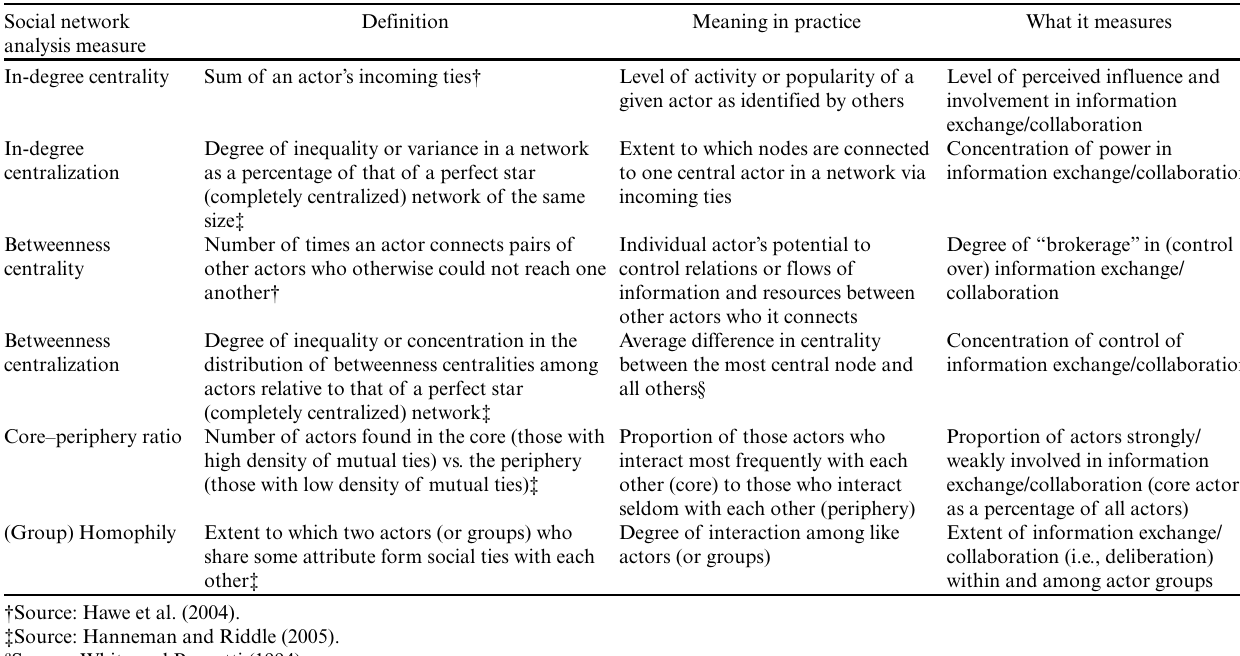
Table 1. Definitions, meanings, and uses of measures employed in analyzing REDD+ policy networks in